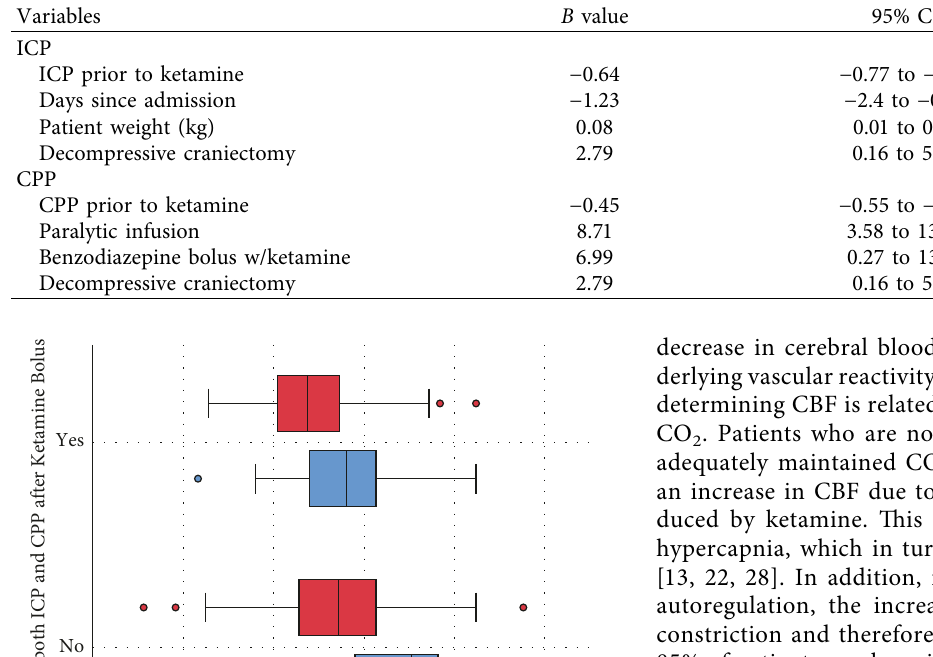
Table 2: Variables independently associated with reduction in ICP and increase in CPP.